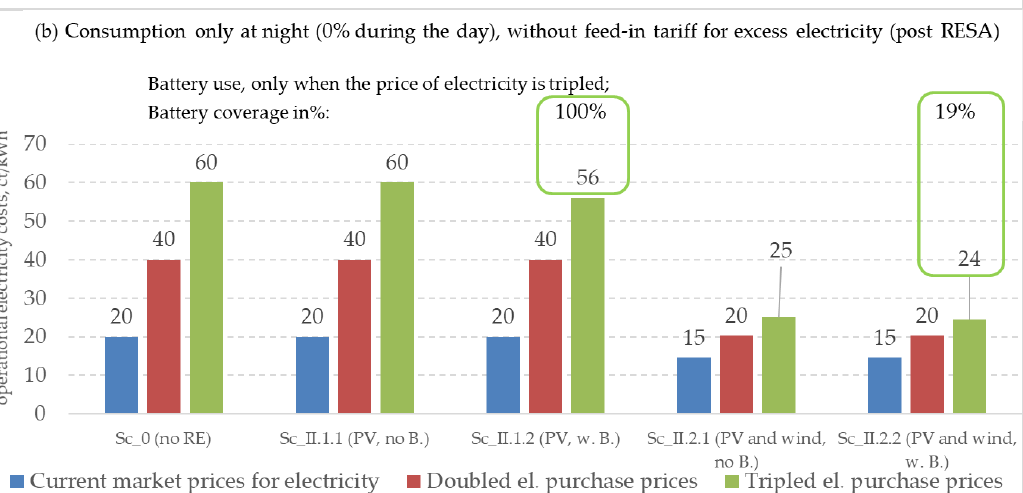
Figure 9. Costs of electricity consumption for an operation with consumption only at night (0% day) for status quo (0.20 ct/kWh) and when electricity price is doubled or tripled and when investing in PV or PV and wind; only when prices triple, with PV power and 100% battery coverage, and with wind and PV and 22% battery coverage (within RESA, a ) or 19% battery coverage (post RESA, b ).